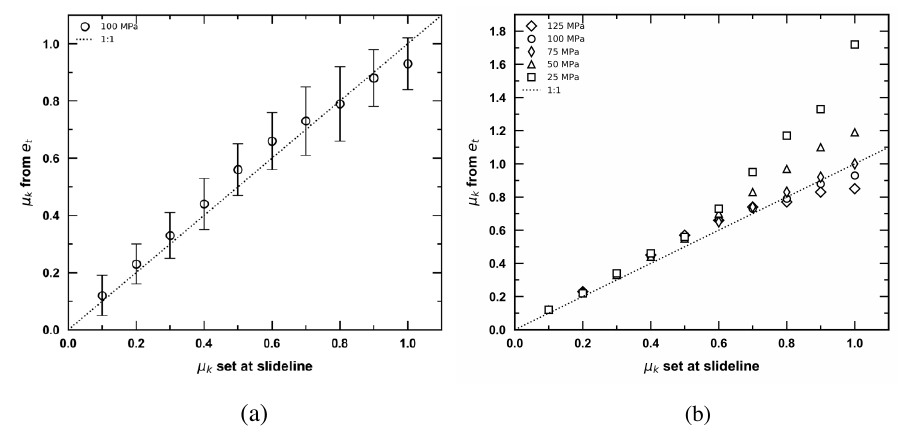
Fig. 5. Comparison of the friction coefficient dictated at the slide interface (slideline) and the average friction coefficient calculated from the resulting transmitted strain for (a) a normal pressure of 100 MPa and (b) normal pressures ranging from 25 to 125 MPa. Error is associated with one standard deviation of the averaged values and the dotted line represents a 1:1 linear